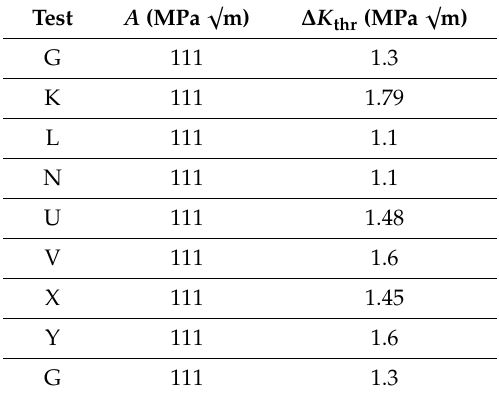
Table 1. Values of A and ∆ K thr used in Figure 2 when computing the crack growth curves for the various tests.